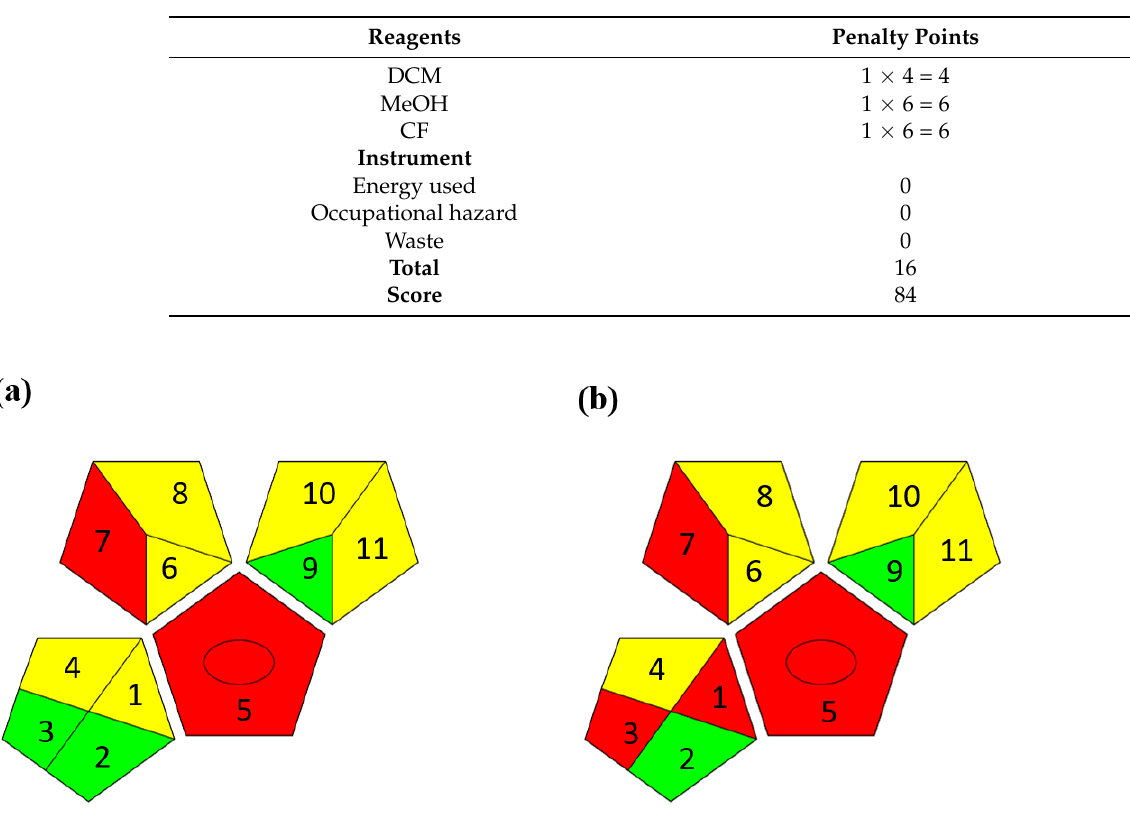
Figure 4. ComplexGAPI pictograms for SA-DLLME TLC-DIC: ( a ) for pharmaceutical samples, and ( b ) for biological samples.